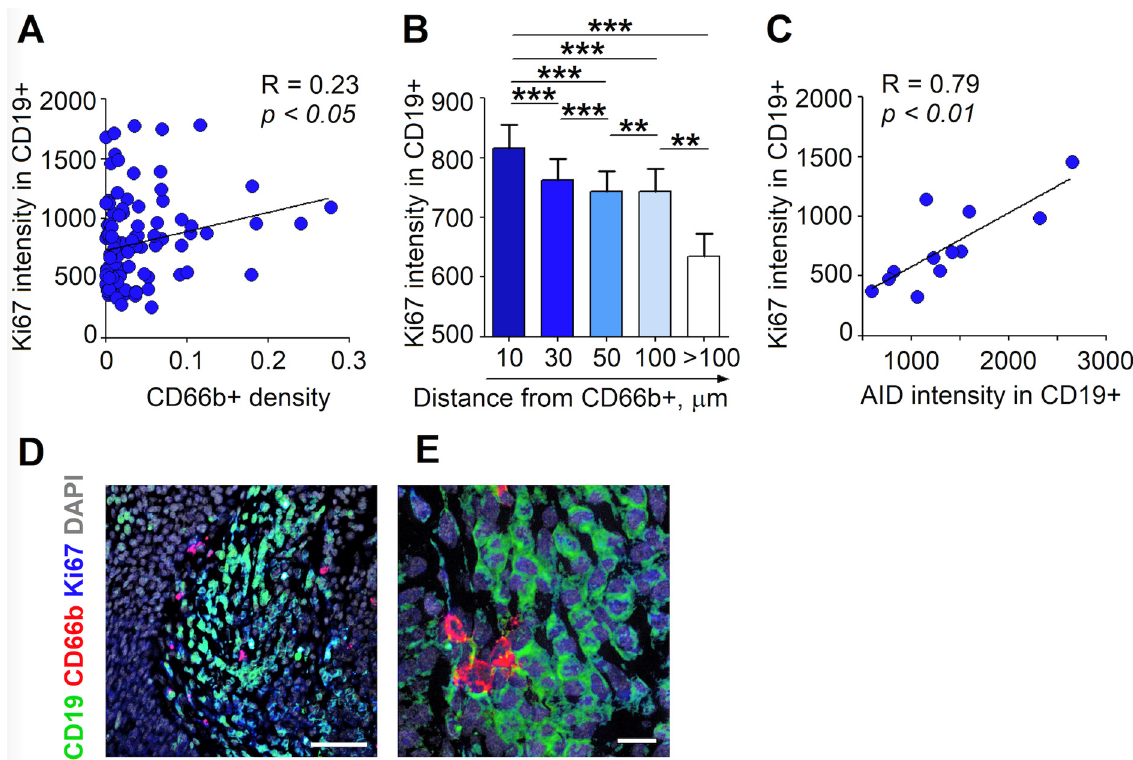
Figure 4. B cells in close proximity to N BH express elevated levels of Ki67. RLNs ( n = 16) of patients with HNC were frozen, and the expression of Ki67 was estimated in CD19+ cells in relation to the distance from CD66b + on cryosections; 3–5 images per individual LN were evaluated. ( A ) Correlation between Ki67 expression in B cells with increasing neutrophil numbers. ( B ) High Ki67 intensity in B cells that are in close proximity to neutrophils. The intensity of Ki67 in B cells in the neutrophil vicinity of 10, 30, 50, 100 and >100 µm were shown. ( C ) Correlation between Ki67 and AID expressions in B cells. ( D , E ) Representative images of the immunofluorescence staining of LN tissues for neutrophils (red), B cells (green) Ki67 (blue) and DAPI (gray). Scale bar, 100 µm ( D ) and 20 µm ( E ). For nonparametrically distributed samples, a Kruskal–Wallis ANOVA with the Bonferroni correction for multiple comparisons and a Wilcoxon test for dependent samples were used. Data are shown as individual values and mean; correlations were estimated with a Spearman rank R test. *** p < 0.001, ** p < 0.01.